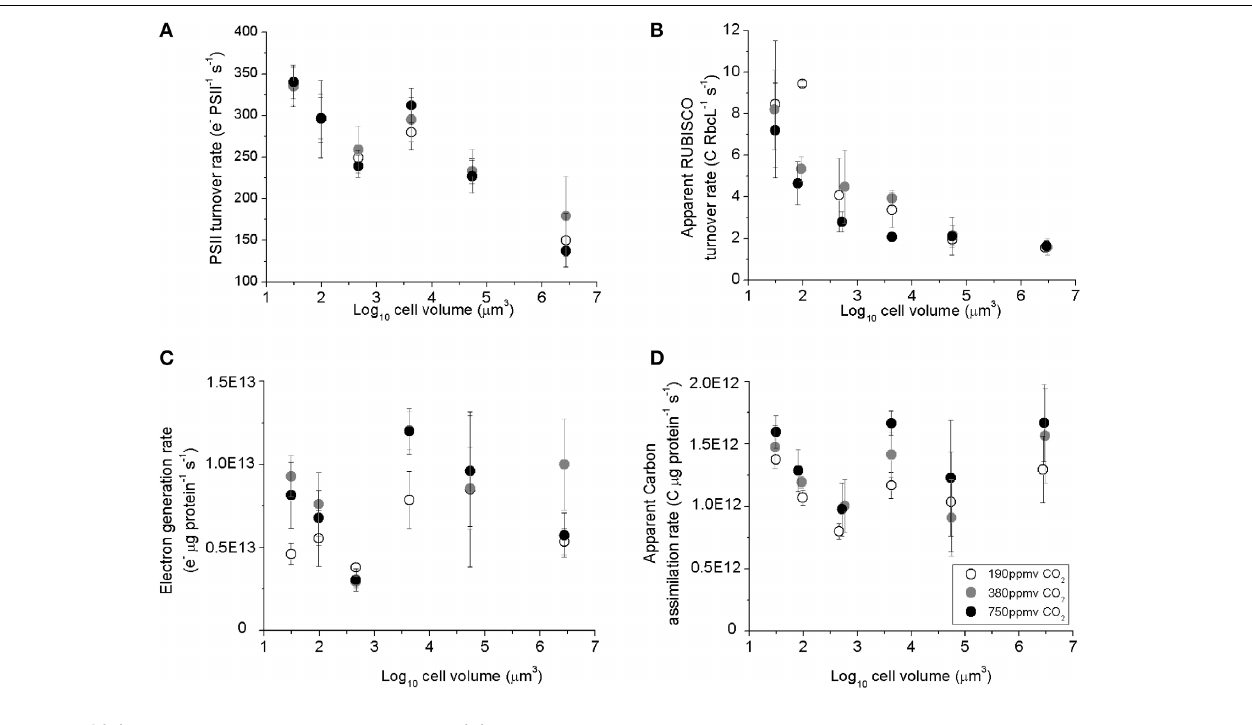
protein, plotted vs. log 10 cell volume. Cultures were grown under p CO 2 190 ppmv (open symbols); 380 ppmv (shaded symbols) or 750 ppmv (black symbols). Vertical error bars indicate standard deviation, n =